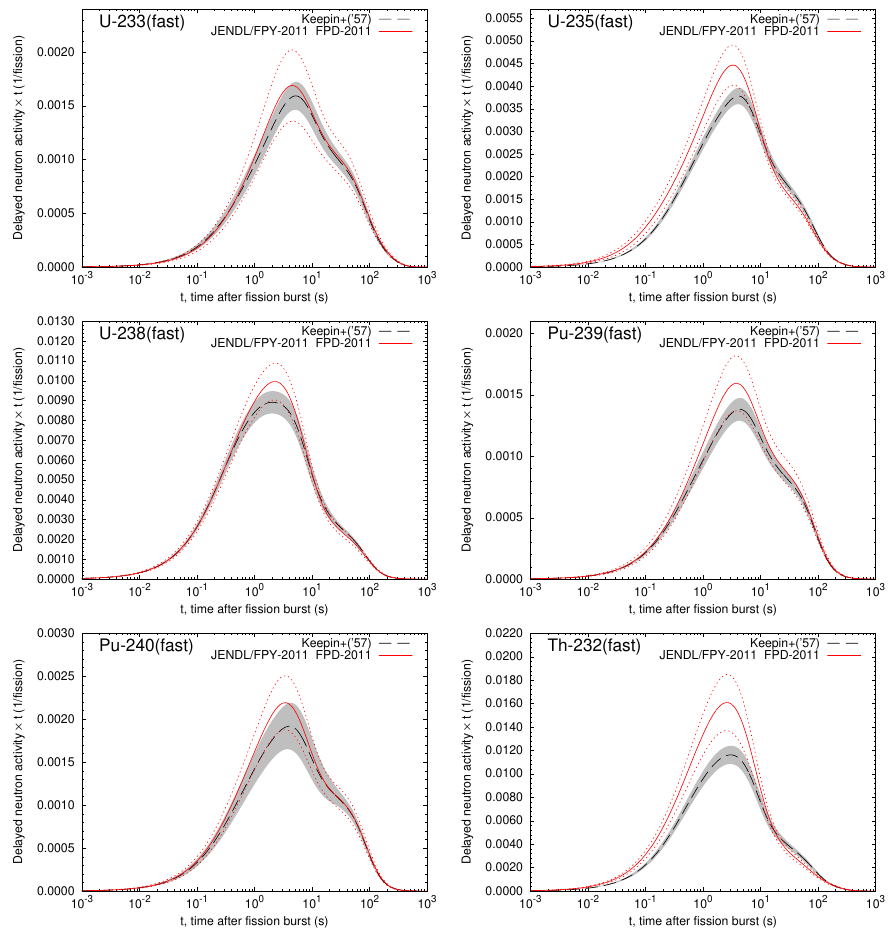
Figure 2. Same as Fig. 1, but for delayed neutron activities for fast neutron induced fission for 233 , 235 , 238 U, 239 , 240 Pu, and 232